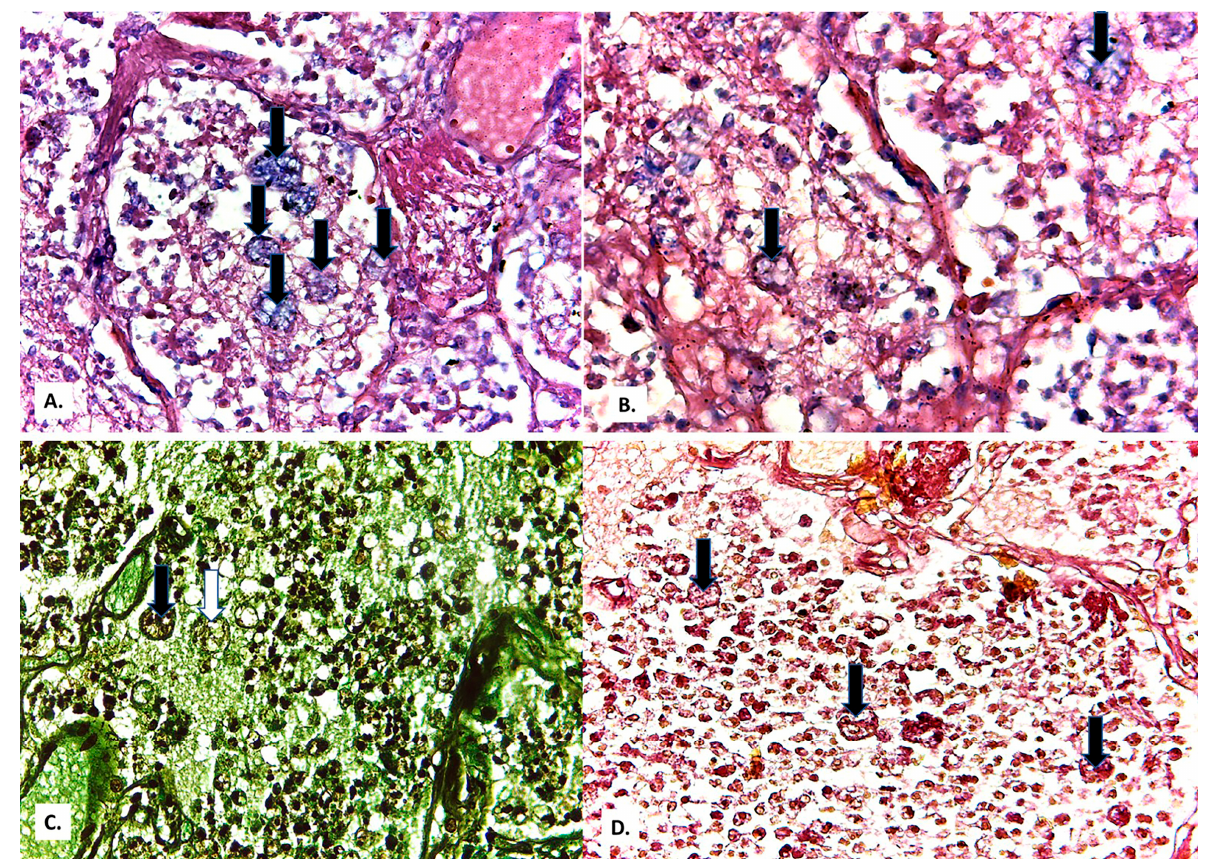
Figure 9. Immunolabeling for iNOS positive only in some macrophages (( A ) microscopic field 1; ( B ) microscopic field 2).